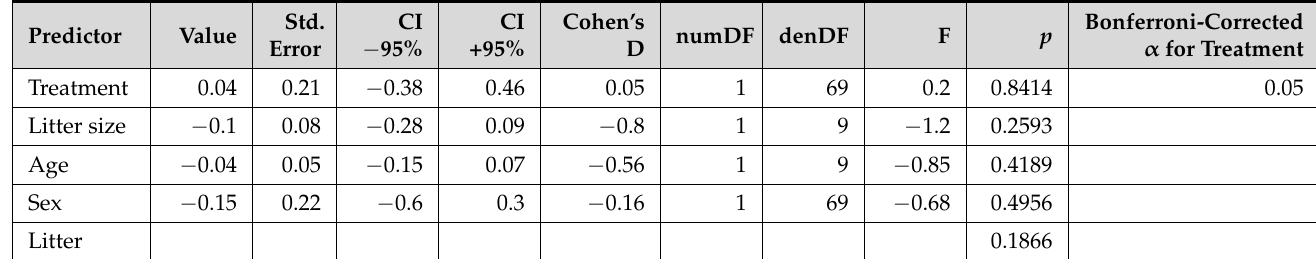
Table 11. Results of the linear mixed-effects model assessing the effect of treatment, age, litter size, and sex on “PC 4—Exploration”. The p -value for litter refers to the ANOVA comparing the models with and without litter included. “Bonferroni-corrected α for treatment” indicates the alpha level (after sequential Bonferroni correction) to determine whether the treatment effect was